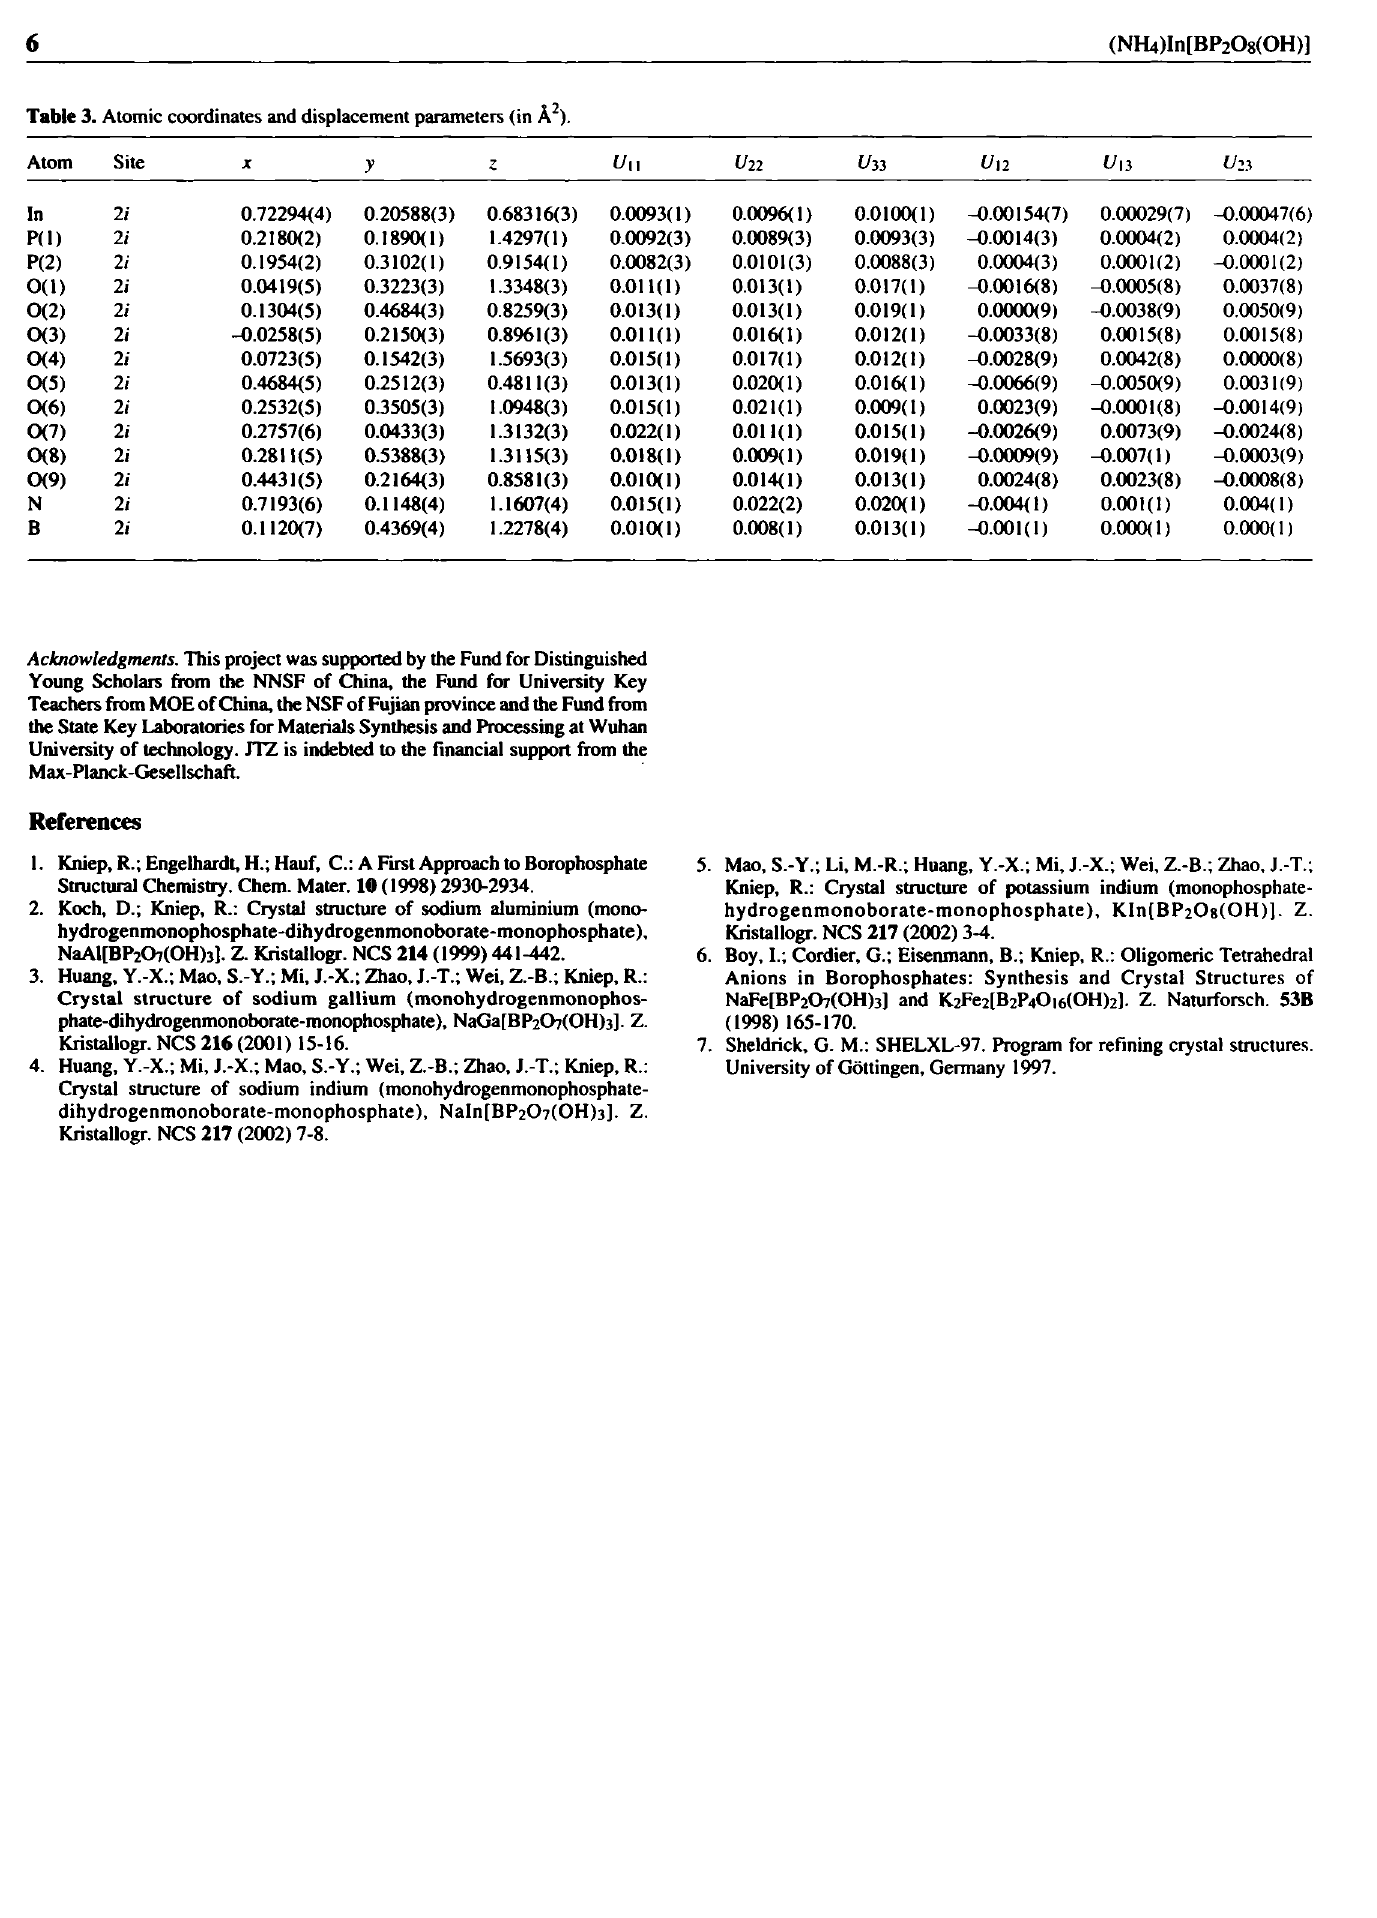
Table 3. Atomic coordinates and displacement parameters (in Â 2